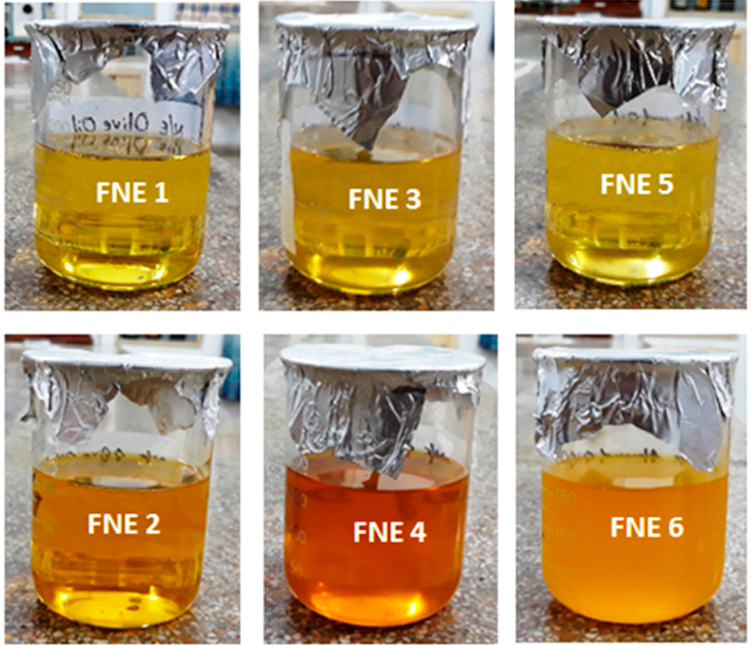
Figure 2. Organoleptic analysis of methotrexate-loaded nanoemulsion.